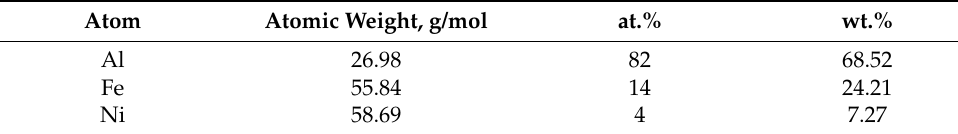
Table 1. The composition of the elemental powder mixture. Atom Atomic Weight, g/mol